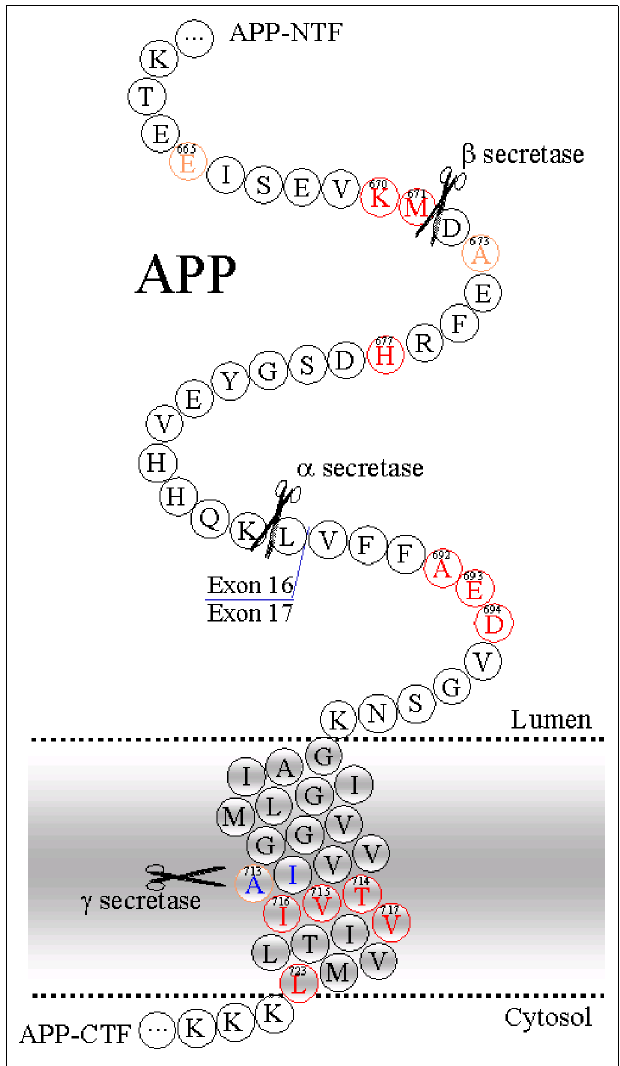
FIGURE 1 |Amino acid sequence